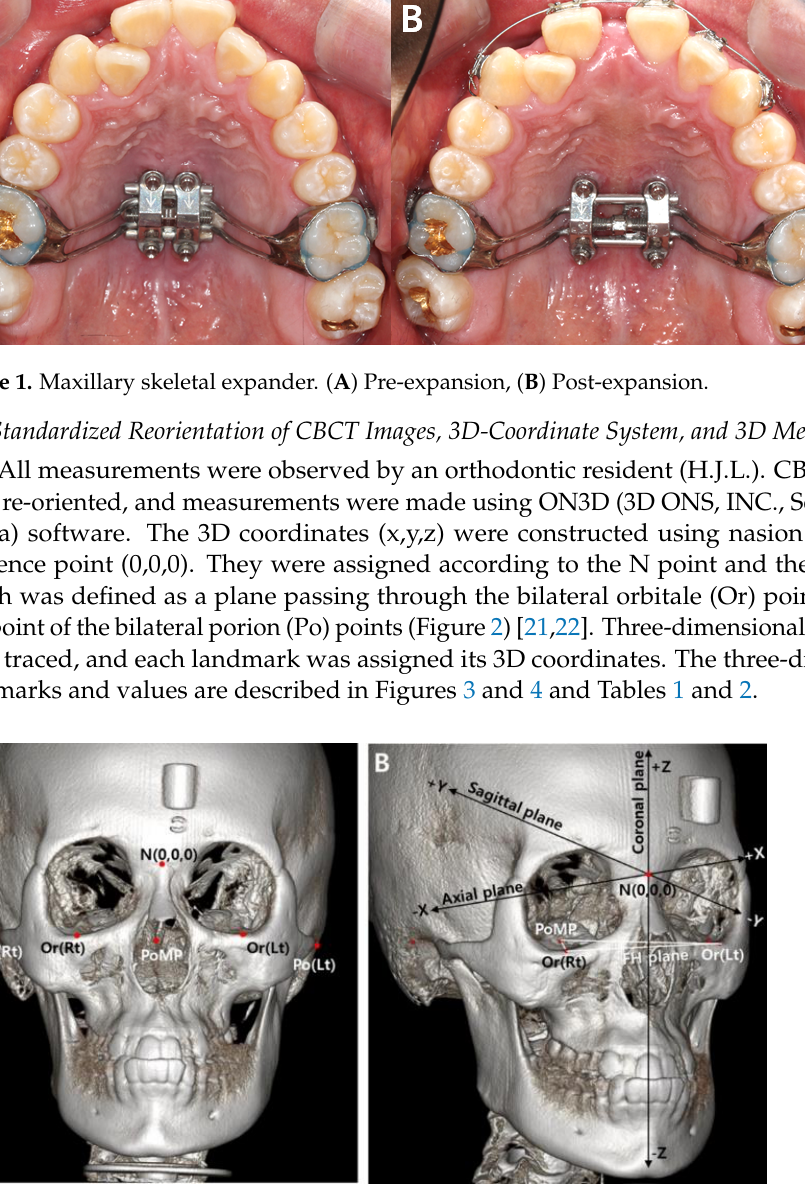
Figure 2. The 3-dimensional coordinate system and standardized reorientation of CBCT Images. ( A ) Frontal view. ( B ) Oblique view. The coordinate system consists of three axes (x, y, and z) with their origin (0,0,0) registered at nasion (N). Frankfort horizontal plane (FH plane) was constructed with bilateral orbitale (Or) points and the midpoint of bilateral porion (Po) points. The x-axis is a transverse axis passing through the N point and also parallel to the FH plane in the frontal view. The y-axis is the anteroposterior axis passing through the N point and perpendicular to the x-axis. The y-axis is parallel to the FH plane in the sagittal plane. The z-axis is the vertical axis perpendicular to both x- and y-axes. Positive values are to the left, posterior, and superior (LPS) to the N point of the subject. Negative values are to the right, anterior, and inferior (RAI) to the N point. PoMP, midpoint of bilateral porion (Po) points. Rt, right. Lt, left.